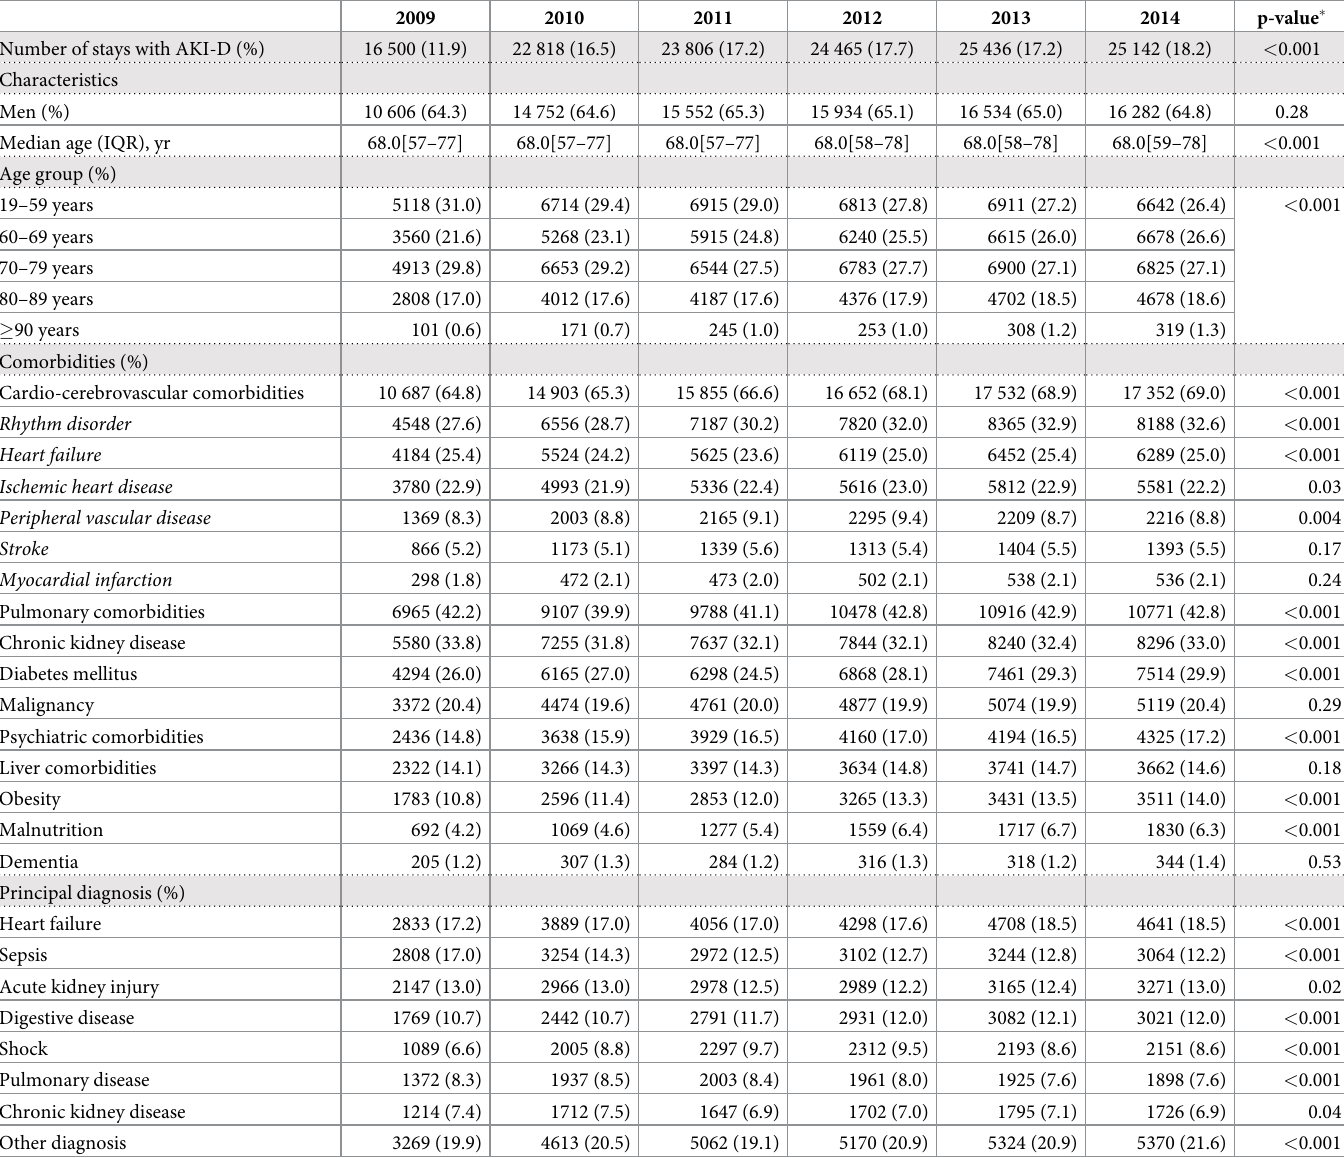
Table 1. Trends in demographic and clinical characteristics of AKI patients requiring dialysis in metropolitan France from 2009 to